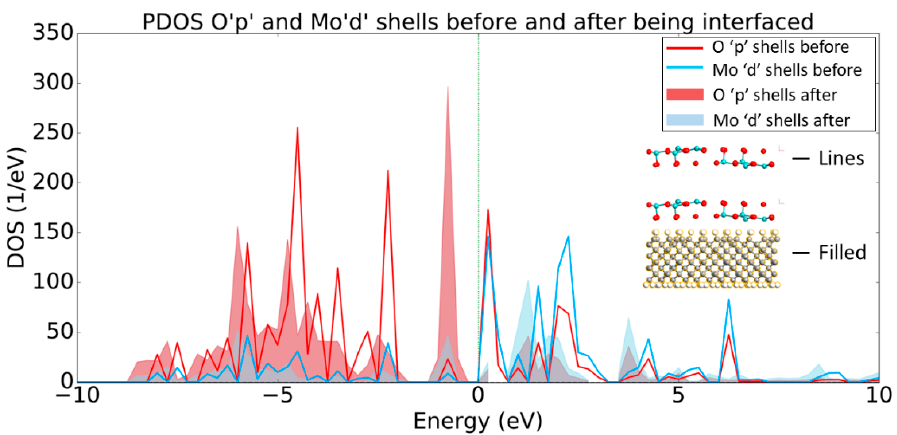
Figure 6. PDOS plot of O p and Mo d shells before (lines) and after (filled) being interfaced with the H-diamond. Inset are two-dimensional (2D) crops of the systems being shown in the PDOS, showing that the line and filled plots denote the MoO 3 before and after being interfaced, respectfully.